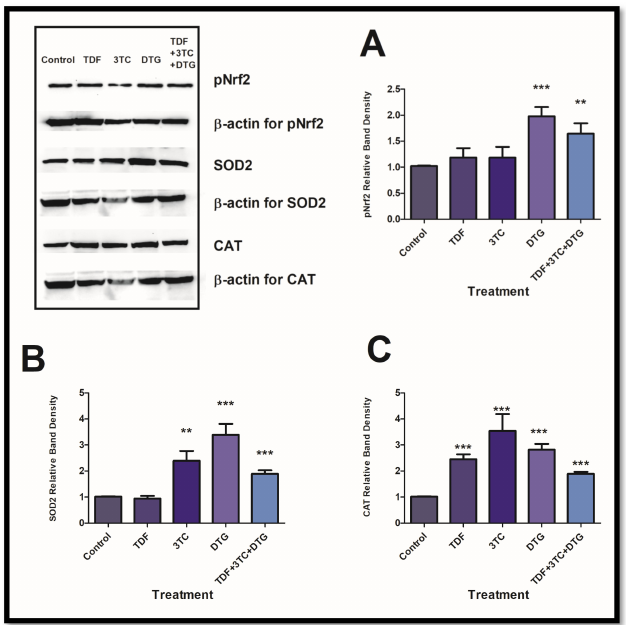
Figure 1. Antiretrovirals activated antioxidant responses. Protein expression of pNrf2 ( A ) and SOD2 ( B ) was significantly increased in selected treatments, whereas all treatments increased protein expression of CAT ( C ). ** p < 0.005, *** p < 0.0001 relative to control (Raw blot images are available in Supplementary Materials: Figures